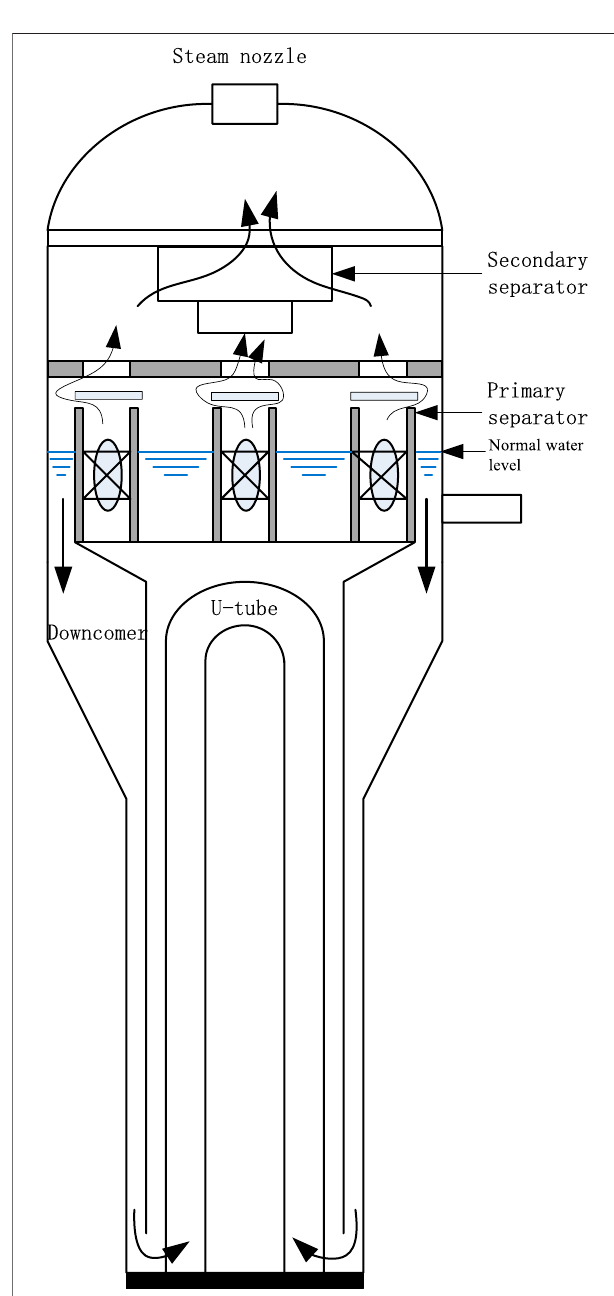
FIGURE 12 | Secondary side structures of U tube